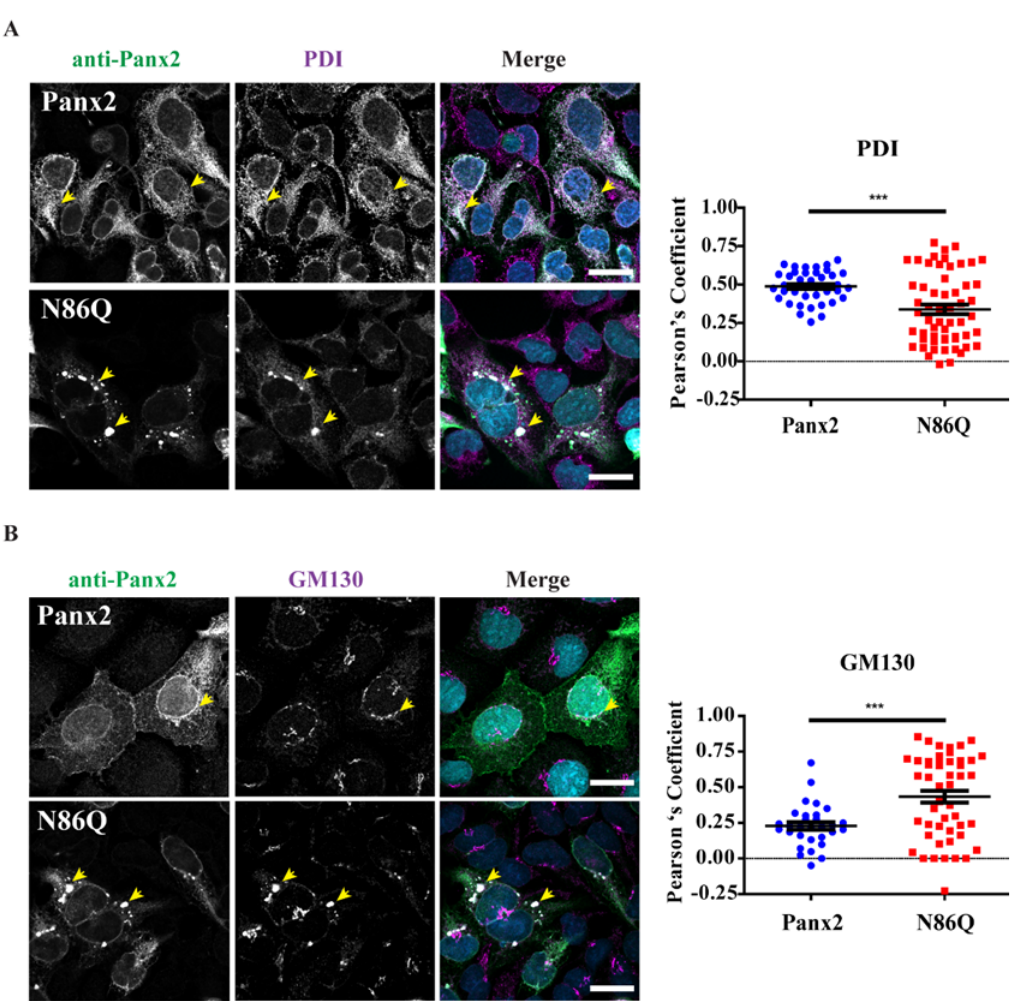
Figure 4. Panx2 and N86Q colocalize with markers of the endoplasmic reticulum and Golgi. Representative confocal micrographs of Panx2 and N86Q ectopically expressed in AD293 cells. Co-immunolabeling with anti-Panx2 antibody (green) and organelle markers (magenta): ( A ) PDI, endoplasmic reticulum (ER); ( B ) GM-130, cis-Golgi matrix. Panx2 has a perinuclear localization and is spread intracellularly in the cytoplasm partially colocalizing with markers of the endoplasmic reticulum and Golgi. N86Q aggregates also overlap with ER and Golgi markers and disrupt their distribution. Yellow arrowheads indicate representative regions of colocalization. Nuclei (blue) were counterstained with Hoechst 33342. Scale bars = 20 µ m. Pearson Correlation Coefficients (right) were calculated for multiple regions of interest (ROI)s corresponding to double-labeled cells. Statistical significance was considered when p < 0.05 (*** p ≤ 0.0001, N = 3 independent experiments), using unpaired two-tailed t test with Welch’s correction. Error bars denote mean ±